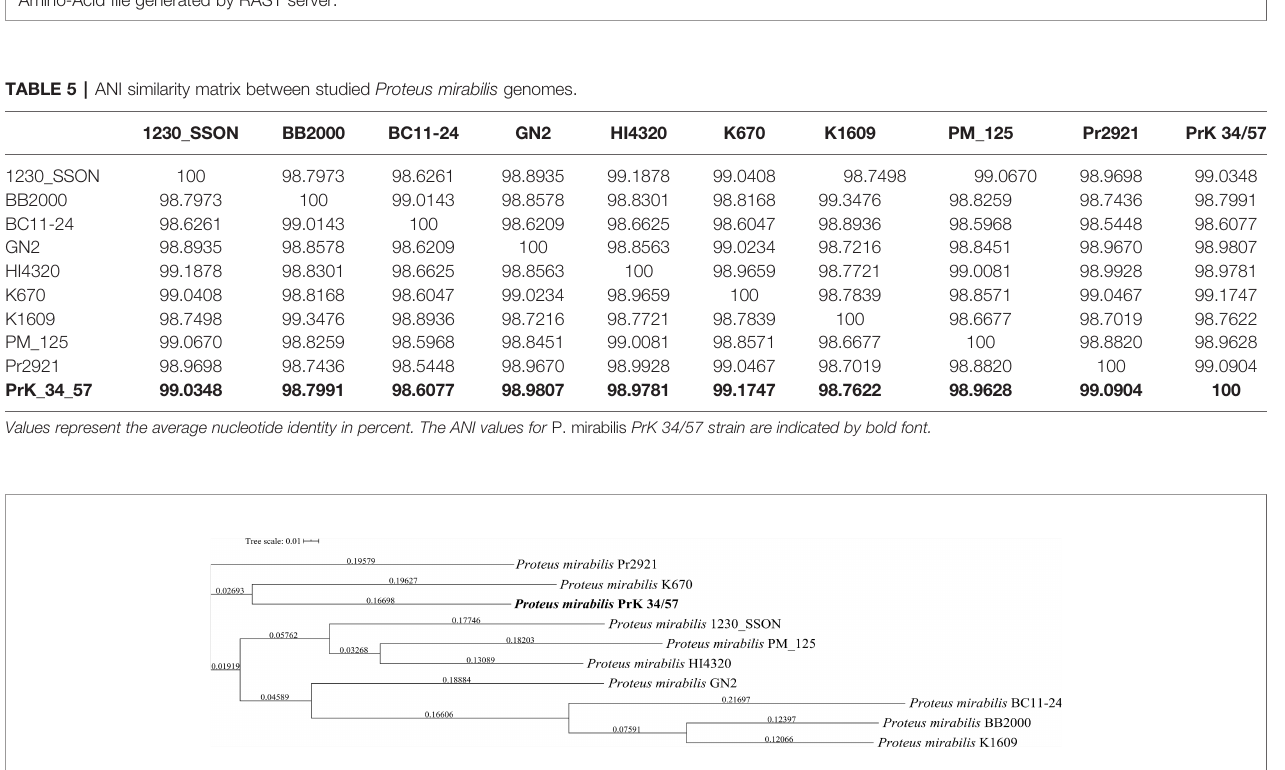
Frontiers in Cellular and Infection Microbiology |